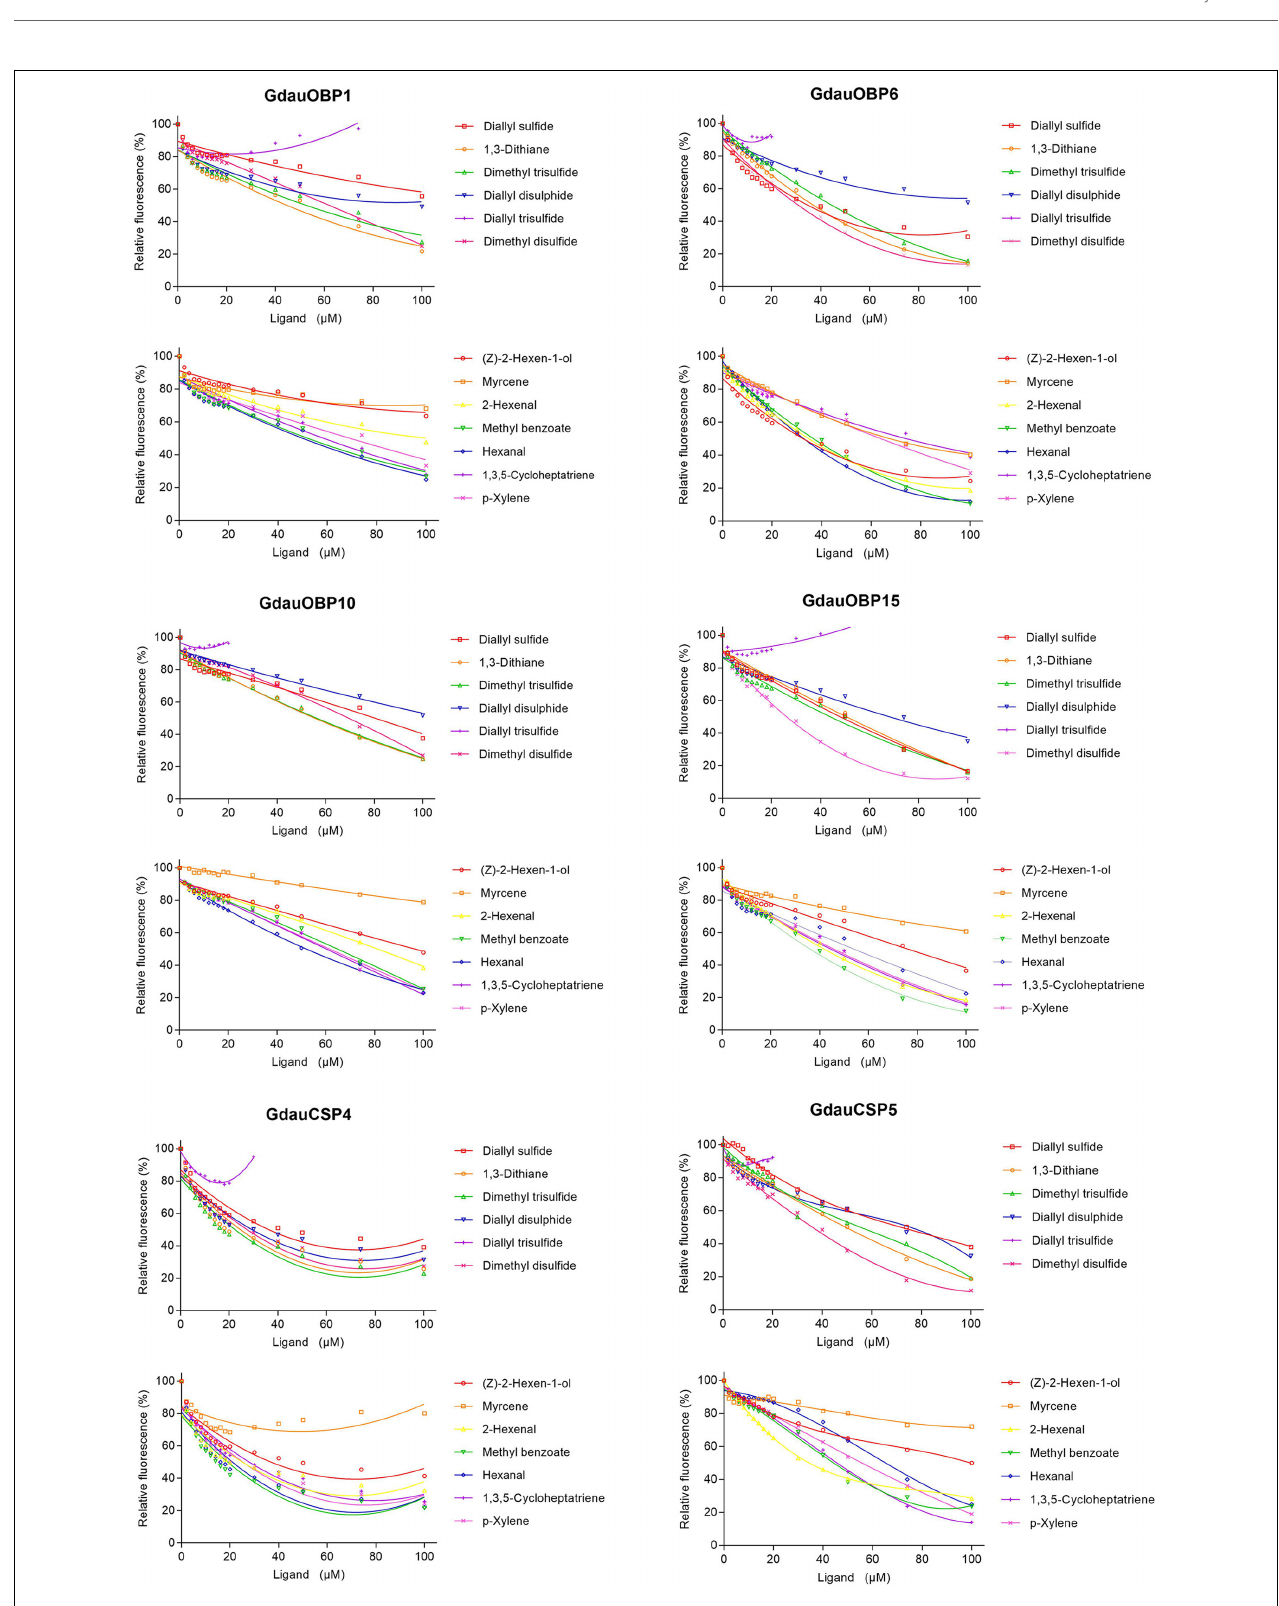
FIGURE 4 | Competitive binding curves of GdauOBP1, GdauOBP6, GdauOBP10, GdauOBP15, GdauCSP4, and GdauCSP5 with thirteen ligands from the host plant volatiles.